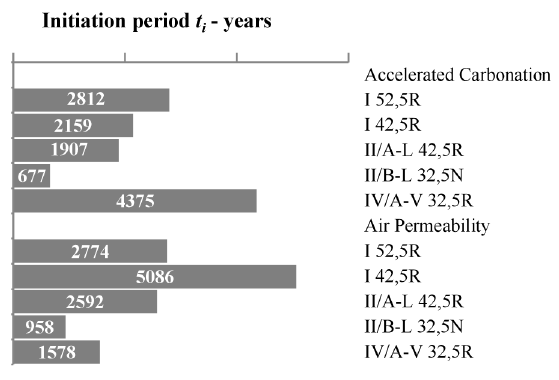
Fig. 5. Design lifetime for target period of 50 years, by accelerated carbonation and air permeability methods, for the exposure class XC4 – humid